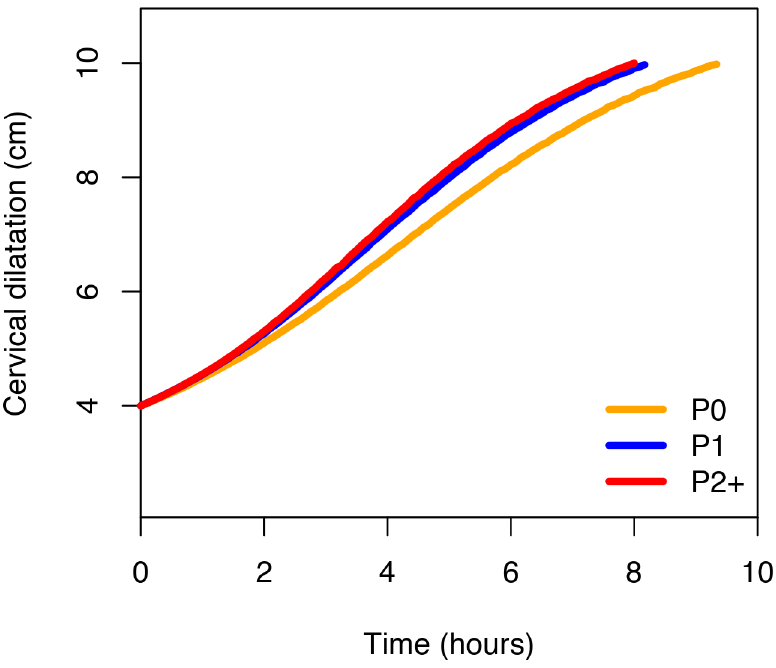
Fig 2. Average labour curves by parity based on multistate Markov models. P0, nulliparous women; P1, parity = 1 women; P2+, parity = 2+ women.